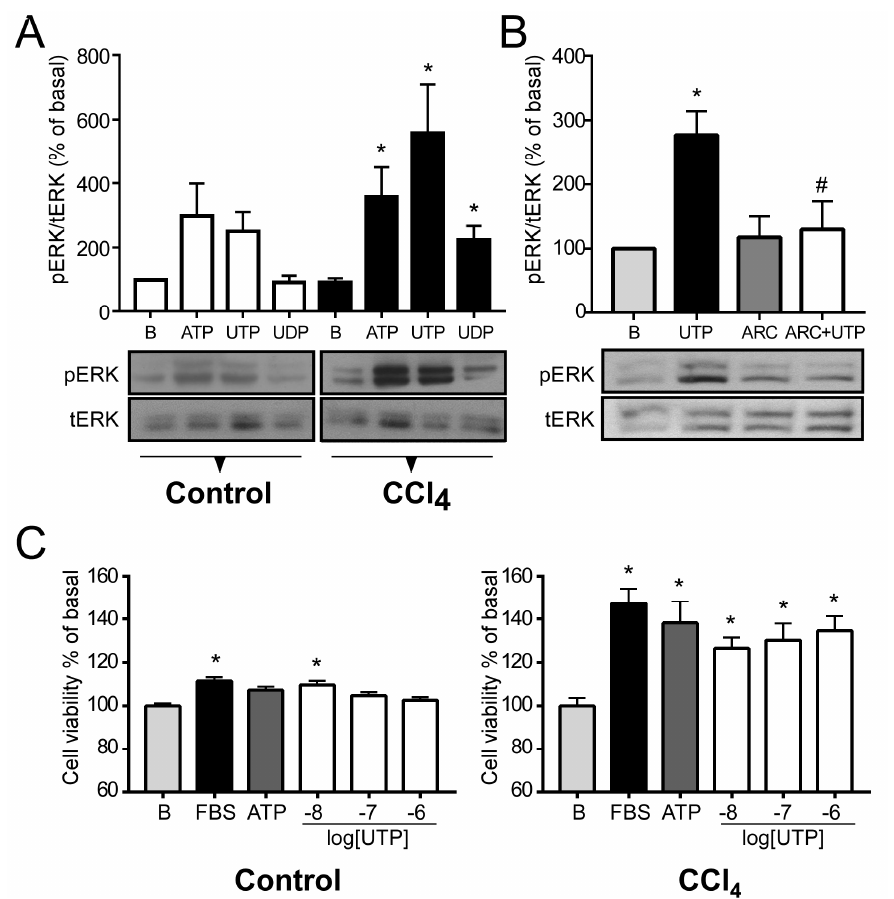
Figure 4. Analysis of P2Y2R function in primary cultured hepatocytes from control and fibrotic mice. ( A ) Induction of ERK phosphorylation by purinergic agonists in hepatocytes isolated from control and